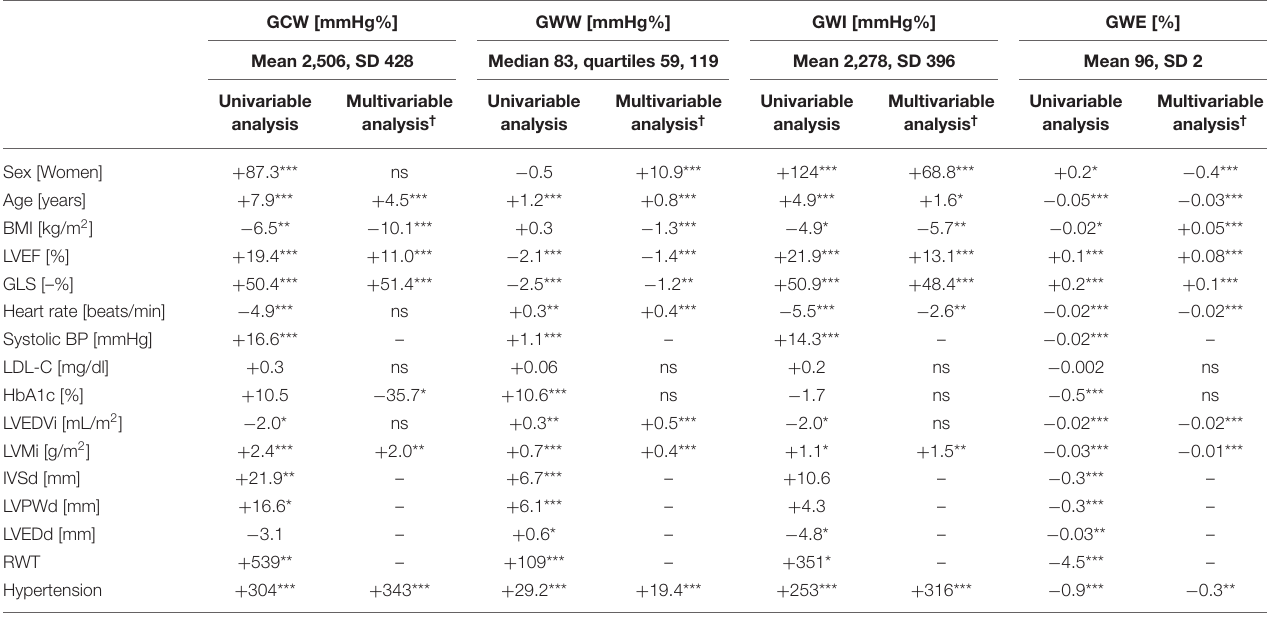
TABLE 3 | Univariable and multivariable regression analysis of myocardial work indices and different echocardiographic